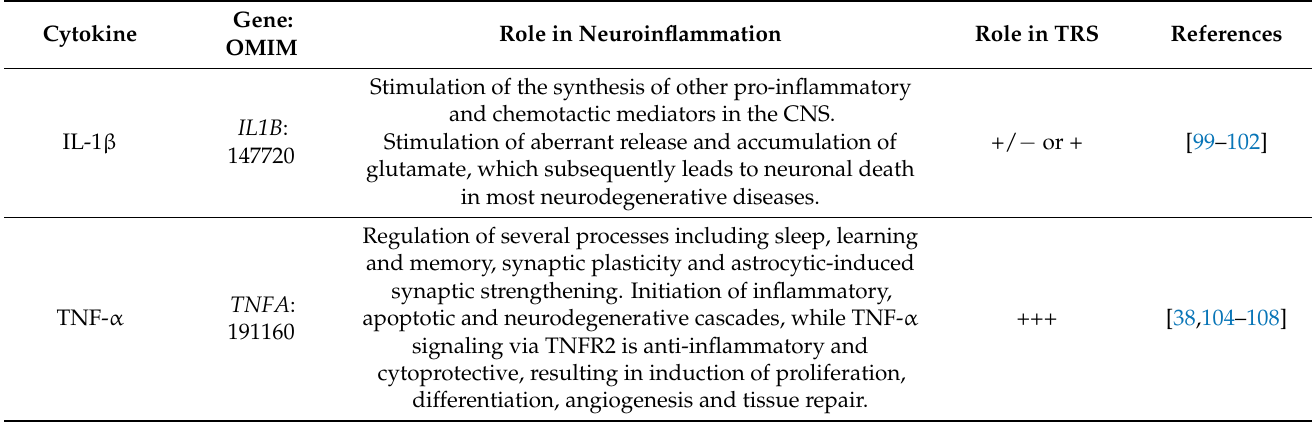
Table 4. Role of pro-inflammatory cytokines in treatment-resistant